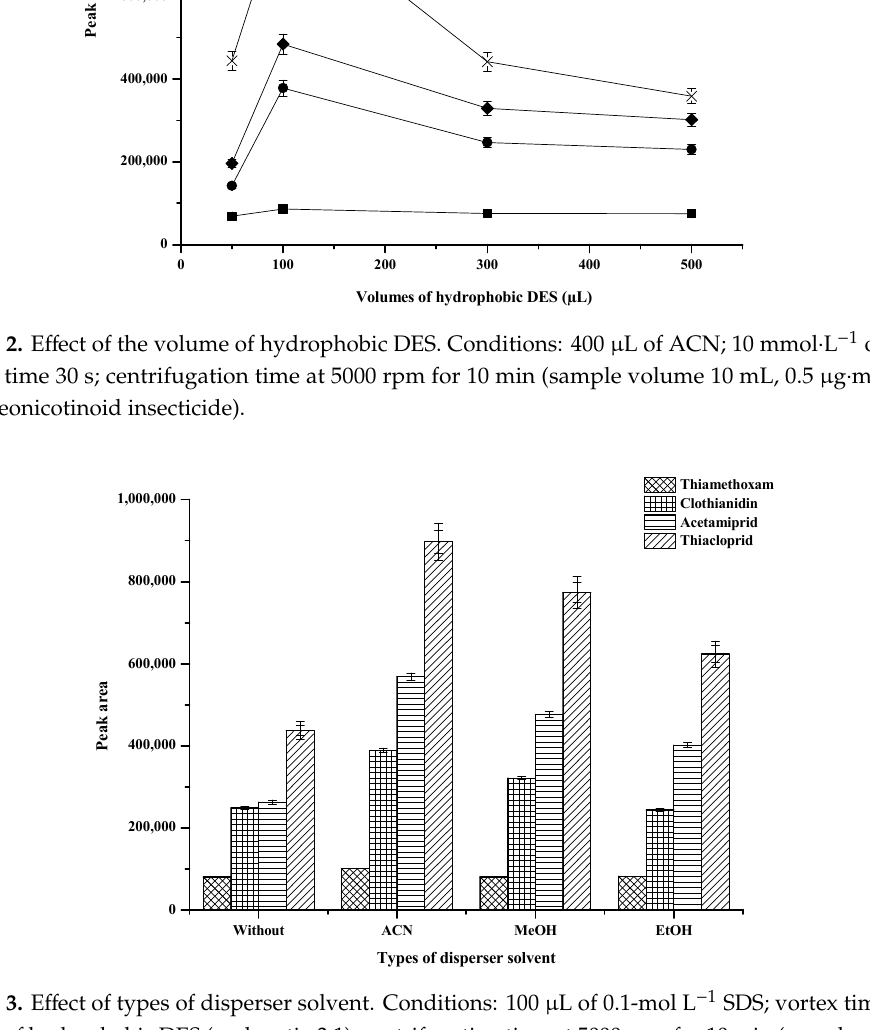
Figure 2. Effect of the volume of hydrophobic DES. Conditions: 400 µL of ACN; 10 mmol·L − 1 of SDS; vortex time 30 s; centrifugation time at 5000 rpm for 10 min (sample volume 10 mL, 0.5 µg·mL − 1 of each neonicotinoid insecticide).